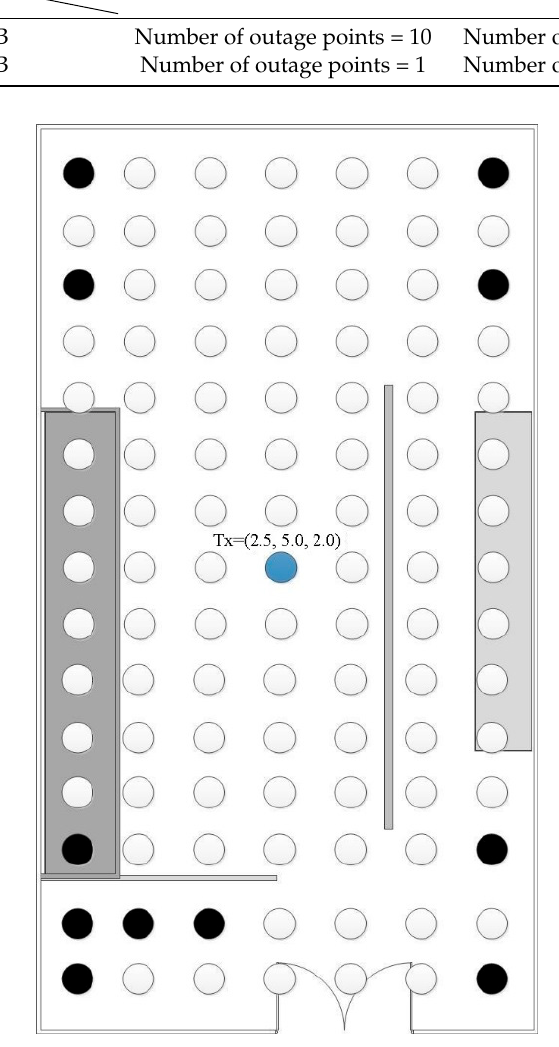
Figure 5. The distribution of the outage points for the transmitter at (2.5, 5.0, 2.0) m. (SNR = 56 dB).